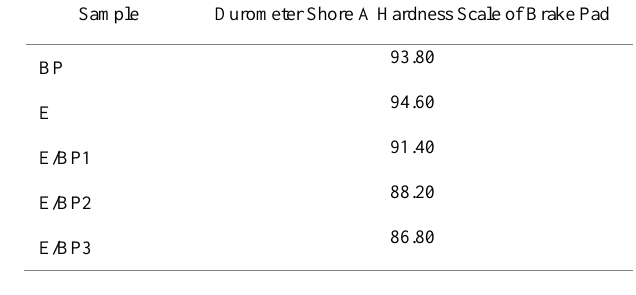
Table 4. Brake pad specimen puncture strength test results